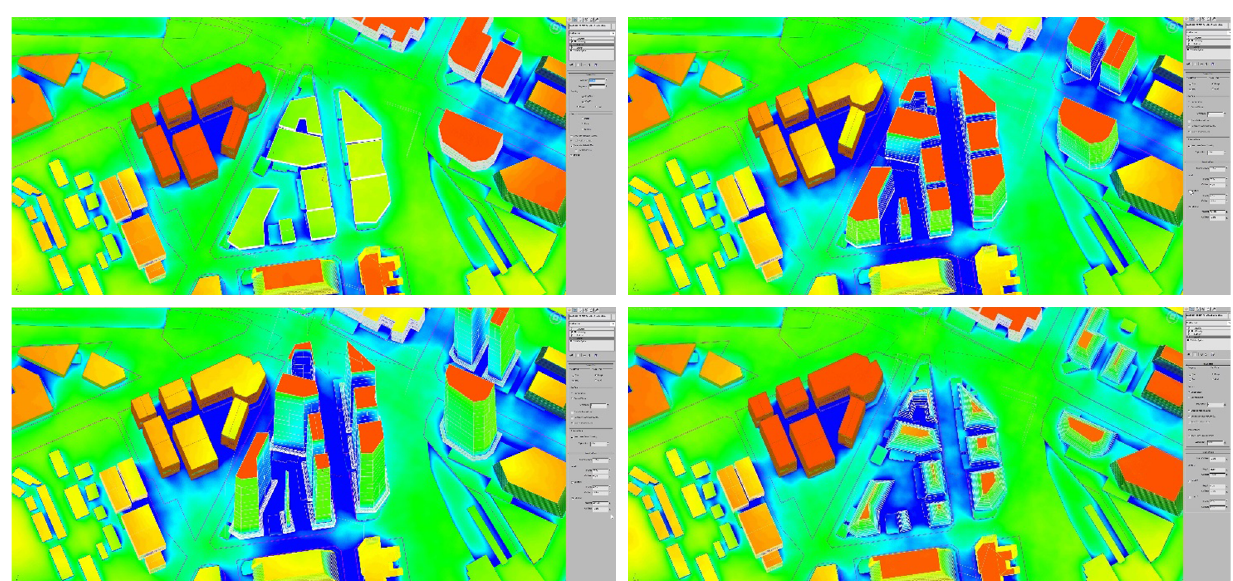
Figure 15. A series of screen grabs showing GPU based SVF calculated in real-time whilst adjusting height, podium size and setback, and tower taper parameter ‘spinners’ controlling potential urban form.